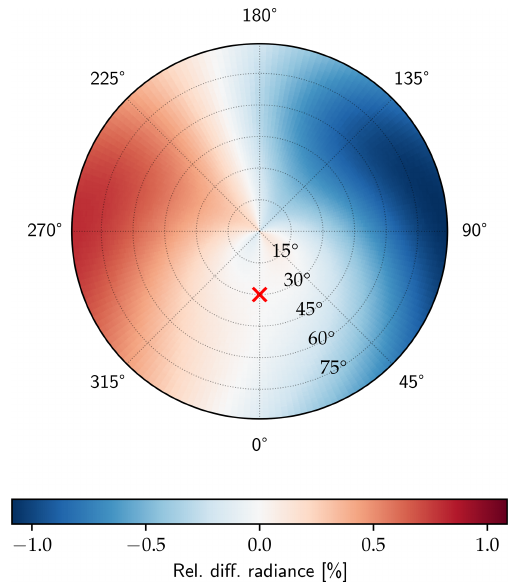
Figure 5. Relative difference in measured total radiance at 500nm due to incorrect rotation and imperfect polarizer for a synthetic scene. The Sun (red marker) is at a zenith angle of 30 ◦ and azimuth 0 ◦